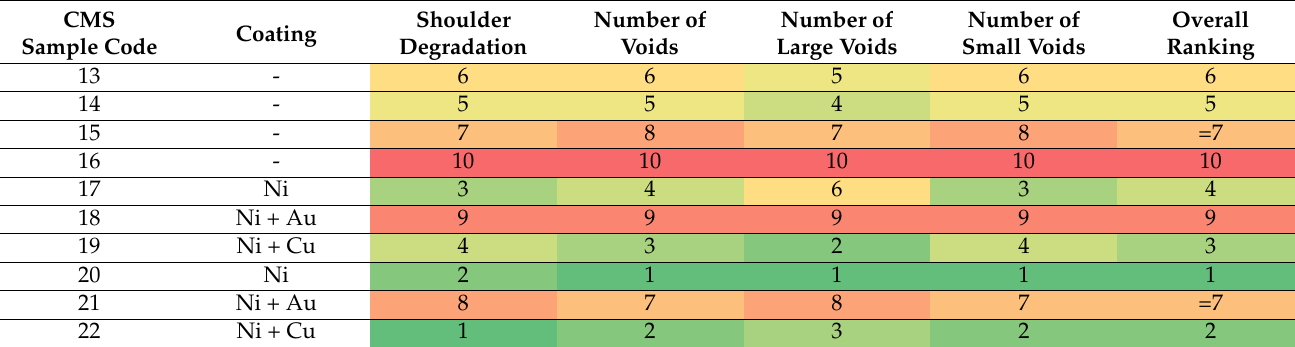
Table 11. Qualitative ranking of the joint samples, where 1 represents the optimal characteristics (in green) sample and 10 represents the worst characteristics (in